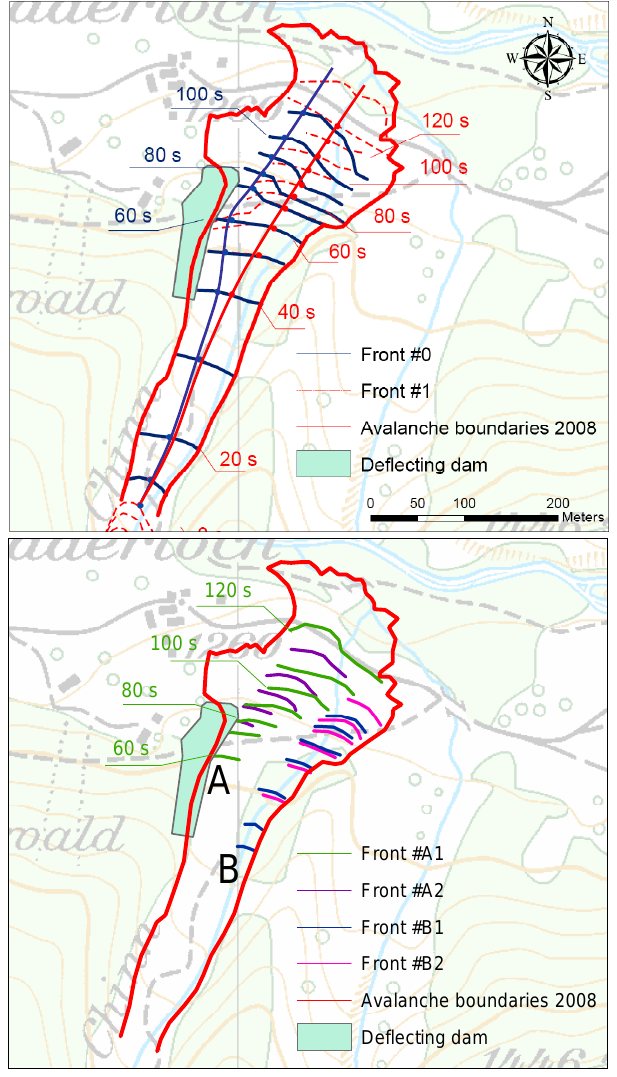
Fig. 10. The upper panel shows avalanche front locations at 10s intervals according to the video sequences. The blue lines show the time position of the most advanced avalanche front (front ] 0), while the red dashed lines show the time position of front ] 1. The lower panel shows the time position of the most relevant roll waves. These waves are generated at topographic